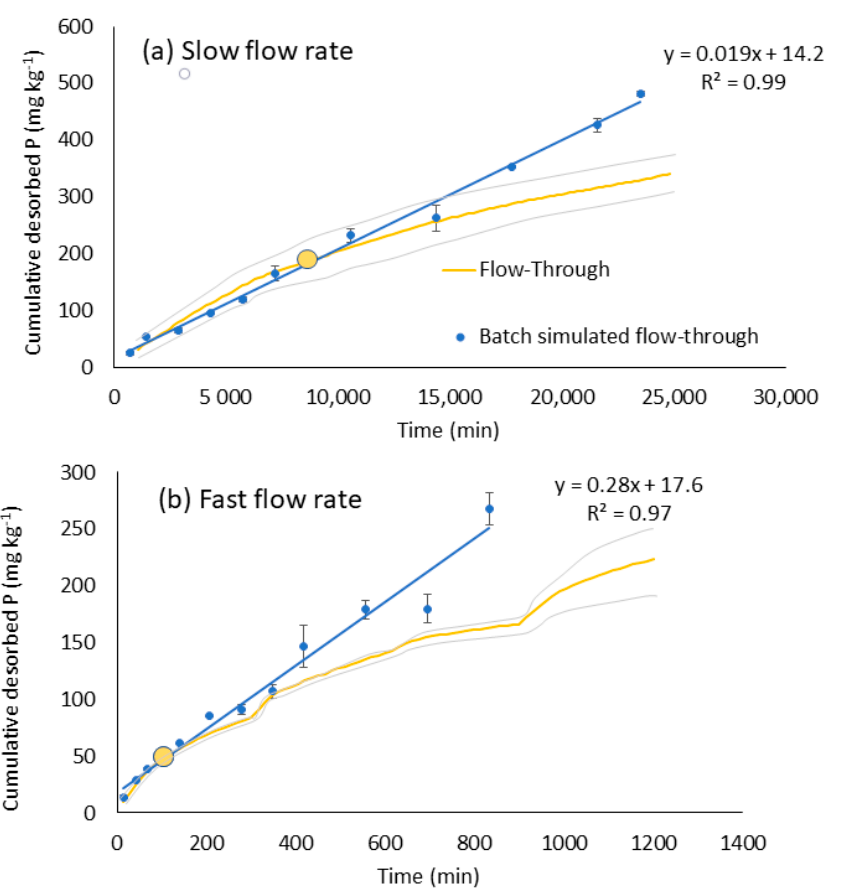
Figure 8. Mean cumulative phosphorus (P) desorption for flow-through compared to the batch simulated flow-through (variable cumulative time and volume), as a function of cumulative flow time for the slow ( a ) and fast ( b ) flow rates. Enlarged circles indicate “breakpoint” where slope significantly ( p < 0.001) decreases for flow-through P desorption. Error bars on batch flow-through simulation indicate standard deviation. Grey lines indicate upper and lower end of standard deviation for flow-through desorption.